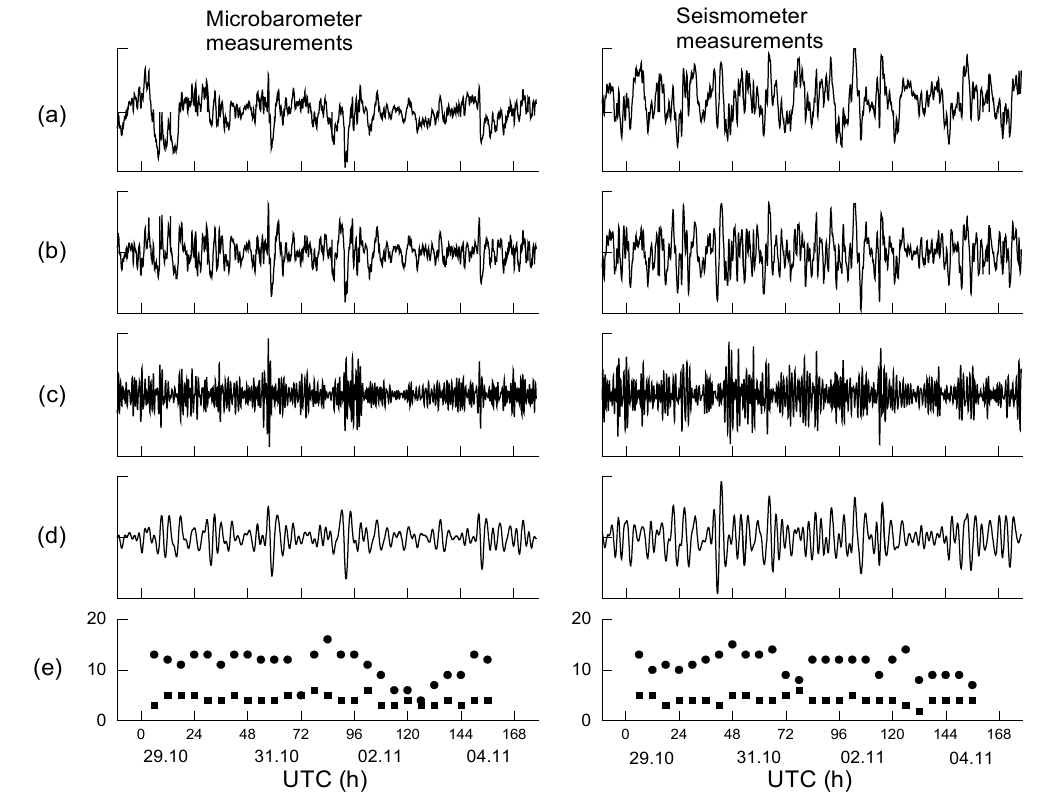
Fig. 2. Fig. 2. Raw records of simultaneous microbarometer and seismometer measurements for 29 October–4 November 1997 (a) . These records after removing the smoothed curve obtained with the sliding 12-h window (b) and a subsequent application of the bandwidth Potter filters for separating the “high-frequency” oscillations in the 42–90min period range (c) and the “low-frequency” oscillations in the 2.5–5h period range (d) . All the series are given in relative units. The numbers of peaks in the spectra of 35-h segments of the records (e) for the “high-frequency” (circles) and “low-frequency” (squares)